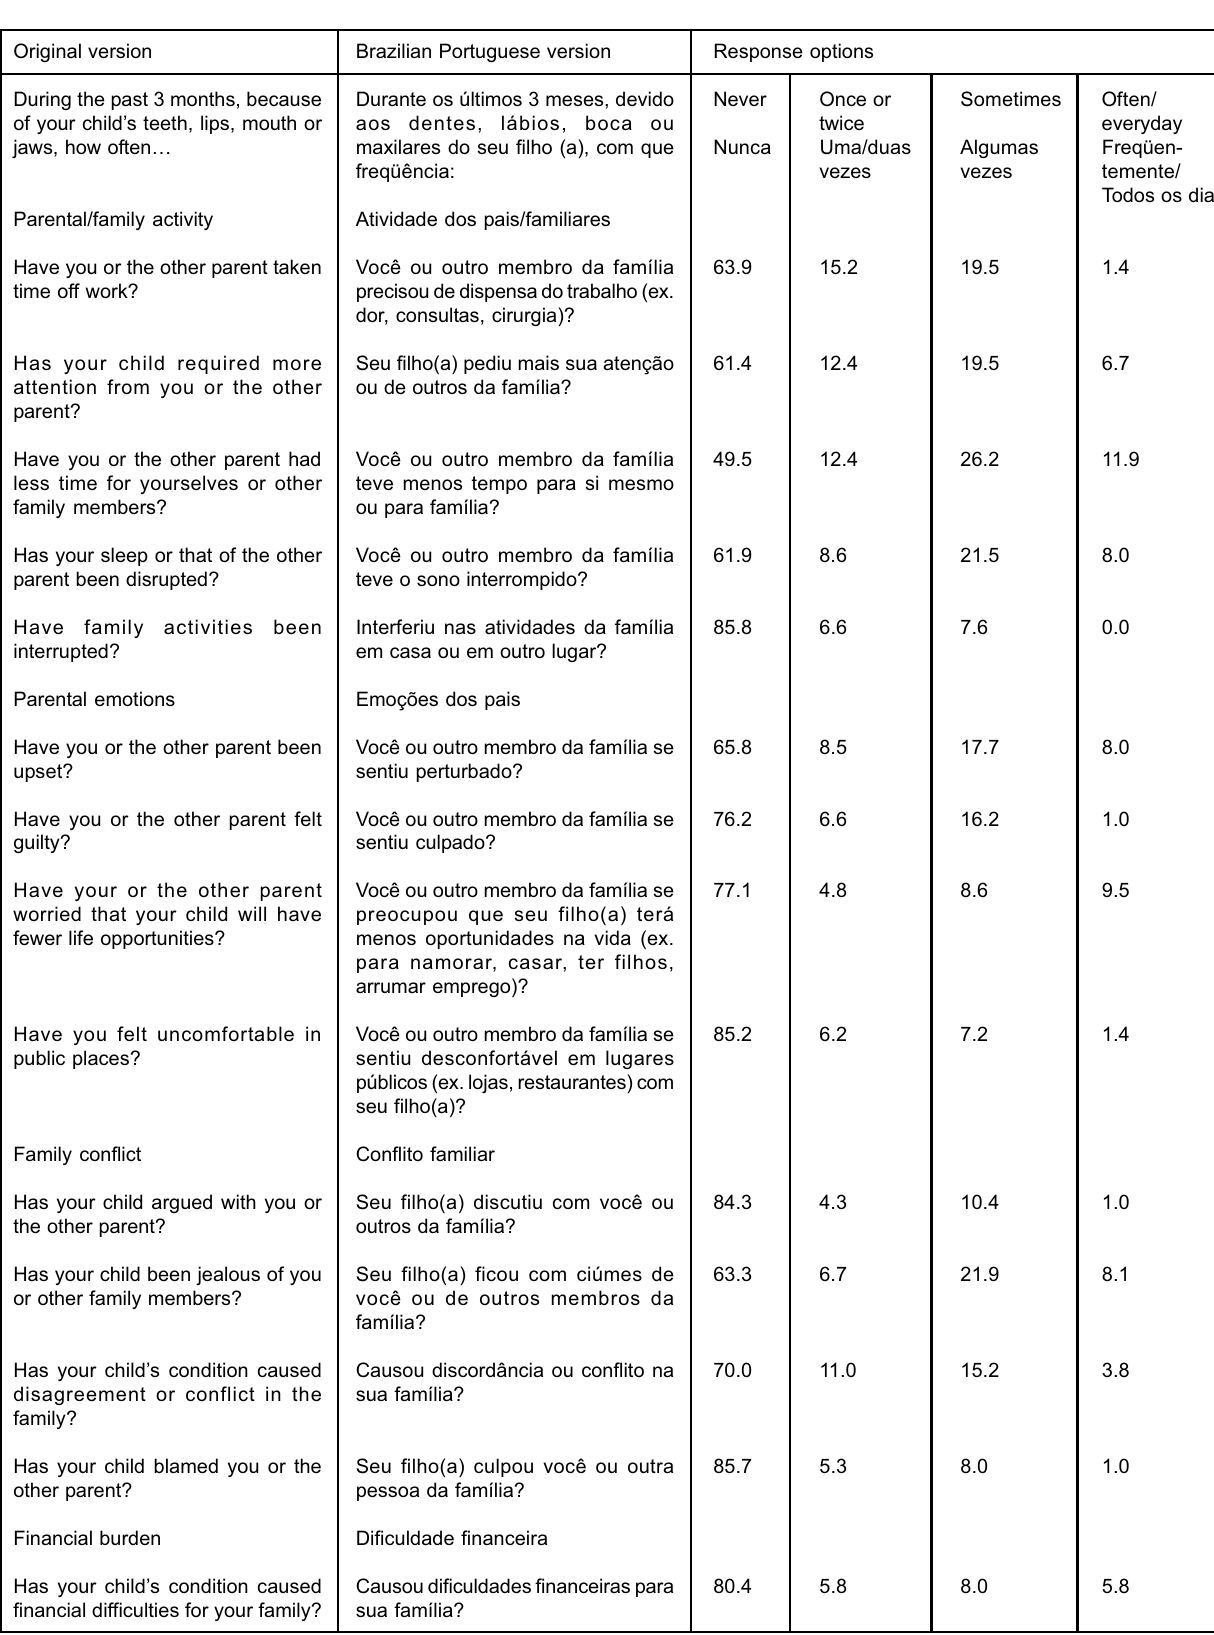
FIGURE 1- Distribution (%) of responses to the family impact items